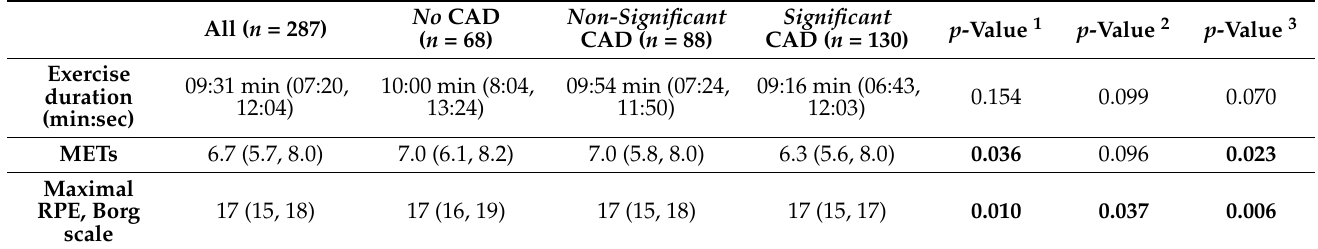
Table 2. Exercise performance in all patients and according to coronary artery disease.